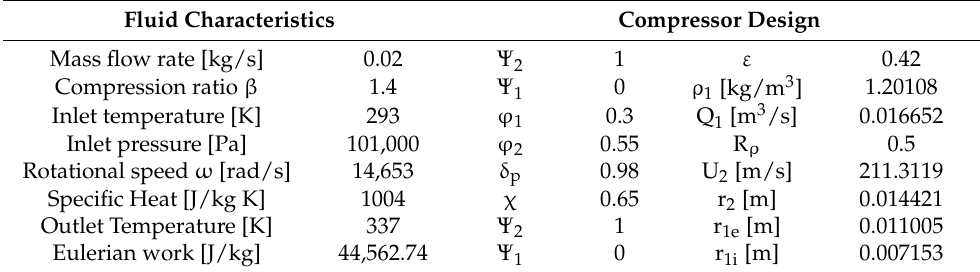
Table 1. Compressor Characteristics.